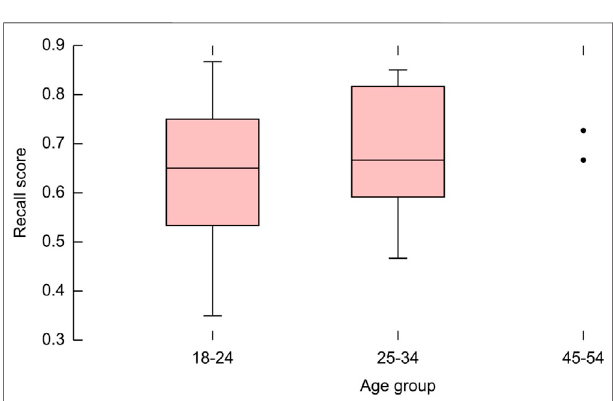
FIGURE 2 | Boxplots of recall scores for participants in different age groups (detailed values in Table 3 ). Notice that no participants were from age group 35 – 44